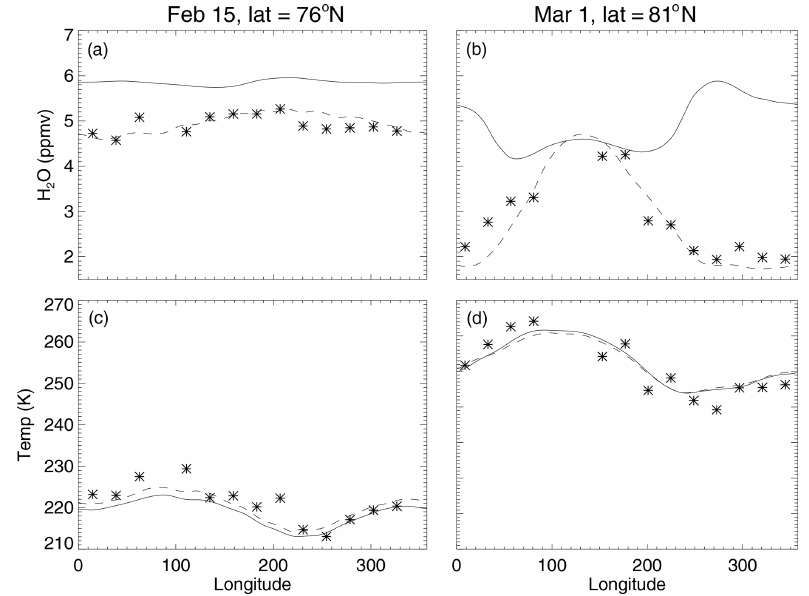
Figure 7. Calculated WACCMX (solid), analyzed NAVGEM-HA (dashed), and observed SOFIE (stars) water vapor (a, b) and temperature (c, d) for p = 0 . 32hPa vs. longitude for the indicated dates and